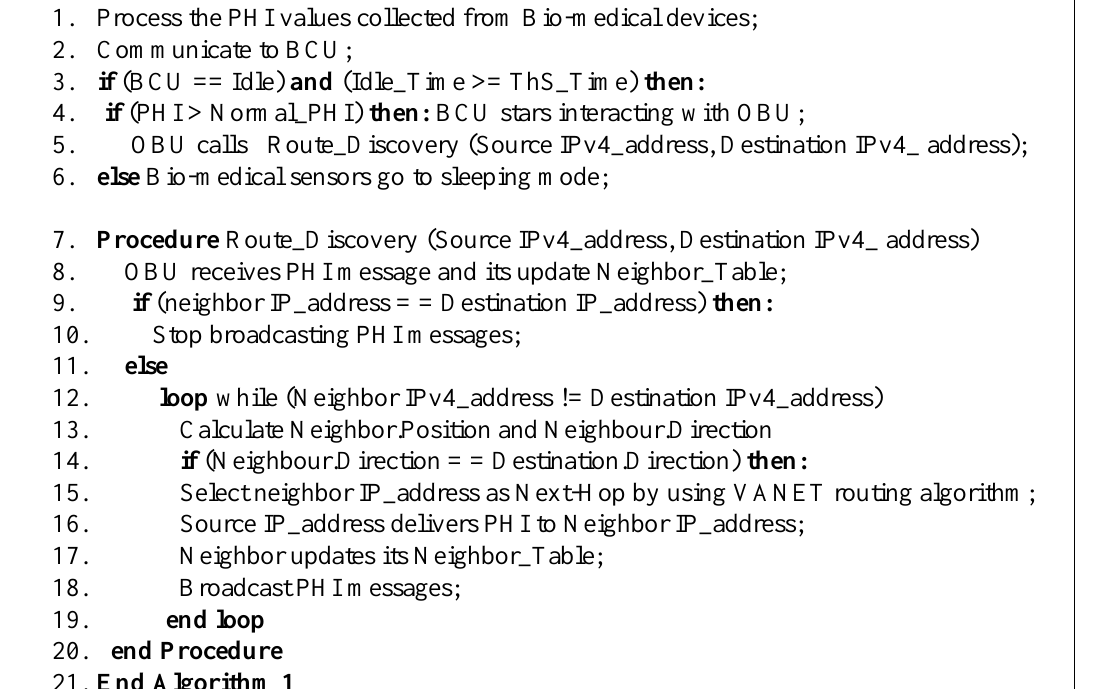
Algorithm 1 Route Establishment and PHI